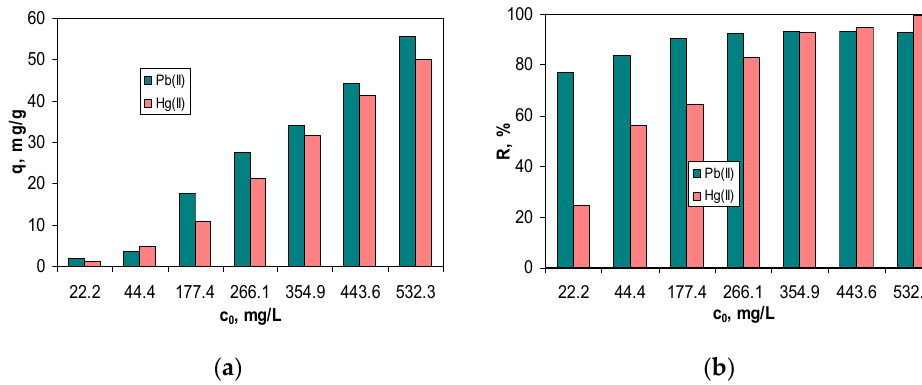
Figure 1 . Effect of initial metal ions concentration on biosorption efficiency of Pb(II) and Hg(II) onto RWB (( a ) variation of biosorption capacity; ( b ) variation of removal percent).